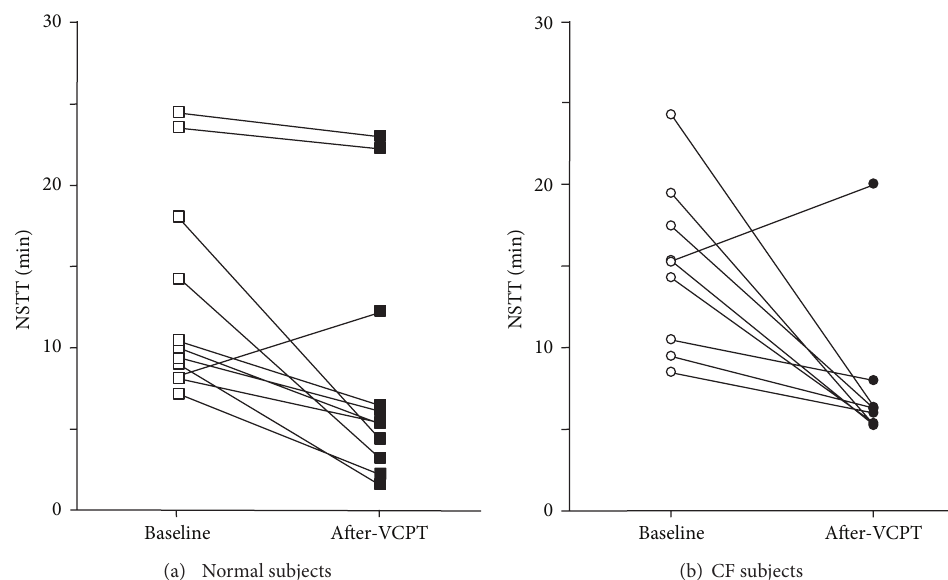
Figure 2: Nasal saccharin transit time (NSTT) after vest chest physiotherapy (VCPT). (a) All but one normal subject demonstrated a decrease in NSTT following vest therapy. (b) All CF subjects except one sustained a decrease in NSTT after VCPT when compared to pretreatment values.